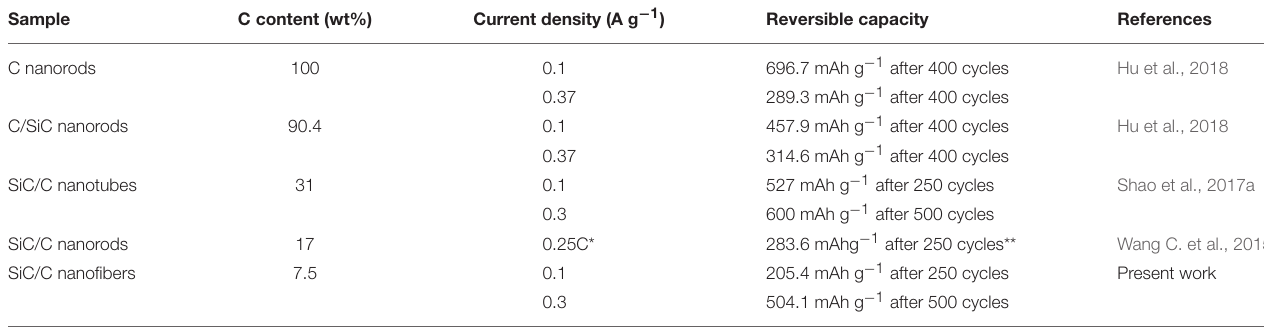
TABLE 1 | Electrochemical performance of SiC-C nanocomposites toward LIBs anode materials.